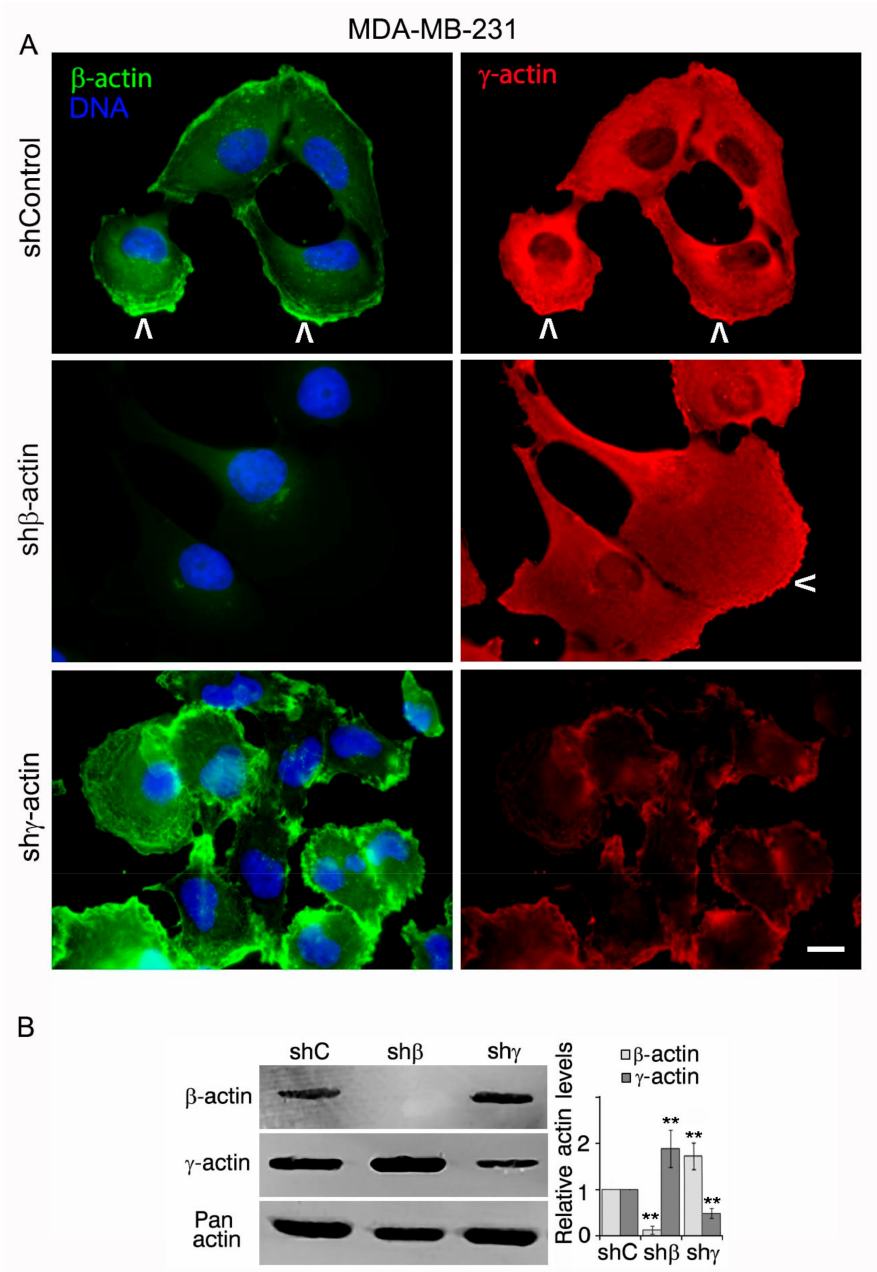
Figure 1. Downregulation of β - or γ -actin expression by corresponding shRNAs in MDA-MB-231 breast cancer cells leads to phenotype changes. ( A ). Immunofluorescent staining of MDA-MB-231 cells with β - or γ -actin downregulation by corresponding shRNAs. Arrowheads mark leading edge with actin enrichment. Bar, 10 µ m. ( B ). Downregulation of cytoplasmic β - or γ -actin in MDA-MB-231 cells. WB analysis. Graphs represent relative actins expression (Mean ± SEM). For cells with shRNA compared with control ( β -actin): p = 0.0015 (shRNA to β -actin); p = 0.007 (shRNA to γ -actin); ( γ -actin): p = 0.0037 (shRNA to β -actin); p = 0.0048 (shRNA to γ -actin); Mann–Whitney U test, n = 3. Values of p < 0.01 (**) were considered as statistically